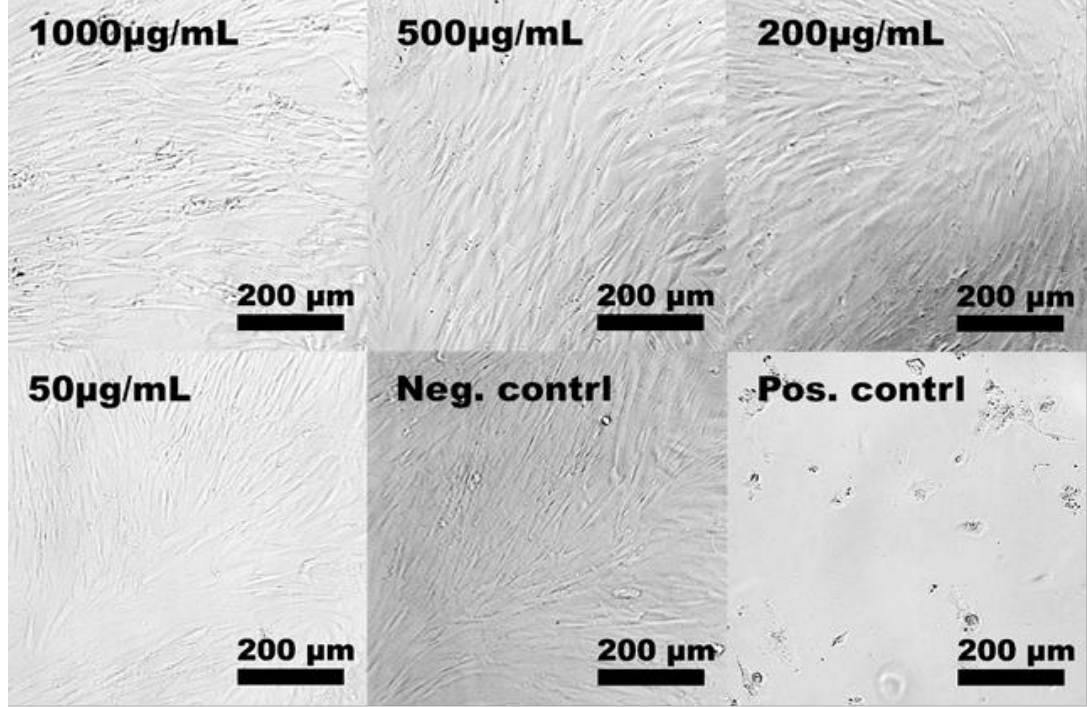
Figure 7. Representative light microscope images of hDF cells exposed to different particle concentrations of aMMC for 48 h. The negative and the positive control samples represent untreated cells and cells that have been exposed to 5% DMSO, respectively.